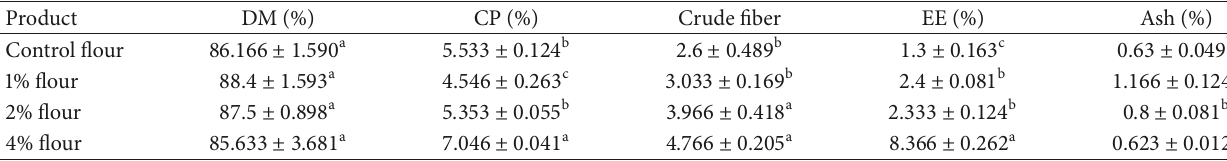
Table 1: Proximate composition of flour with added 𝛽 -glucan compared to the control flour.